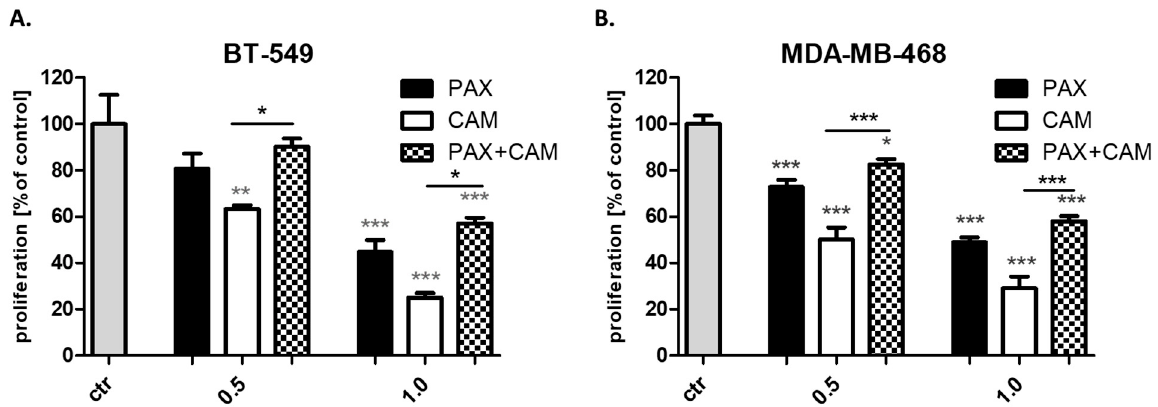
Figure 4. The proliferation of ( A ) BT-549 and ( B ) MDA-MB-468 TNBC cells in the BrdU assay after CAM and PAX treatment. BC cells were incubated for 48 h individually (control) or with the drugs (0.5 = 1 / 4 IC 50 ; 1.0 = 1 / 2 IC 50 determined in the MTT assay). Statistical test: one-way ANOVA, Tukey post-hoc testing. * p < 0.05, ** p < 0.01, *** p < 0.001. Data are presented as mean ± standard deviation of the mean ( ± SD). Grey *-data vs. ctr; black *-single treatment vs. combined treatment.